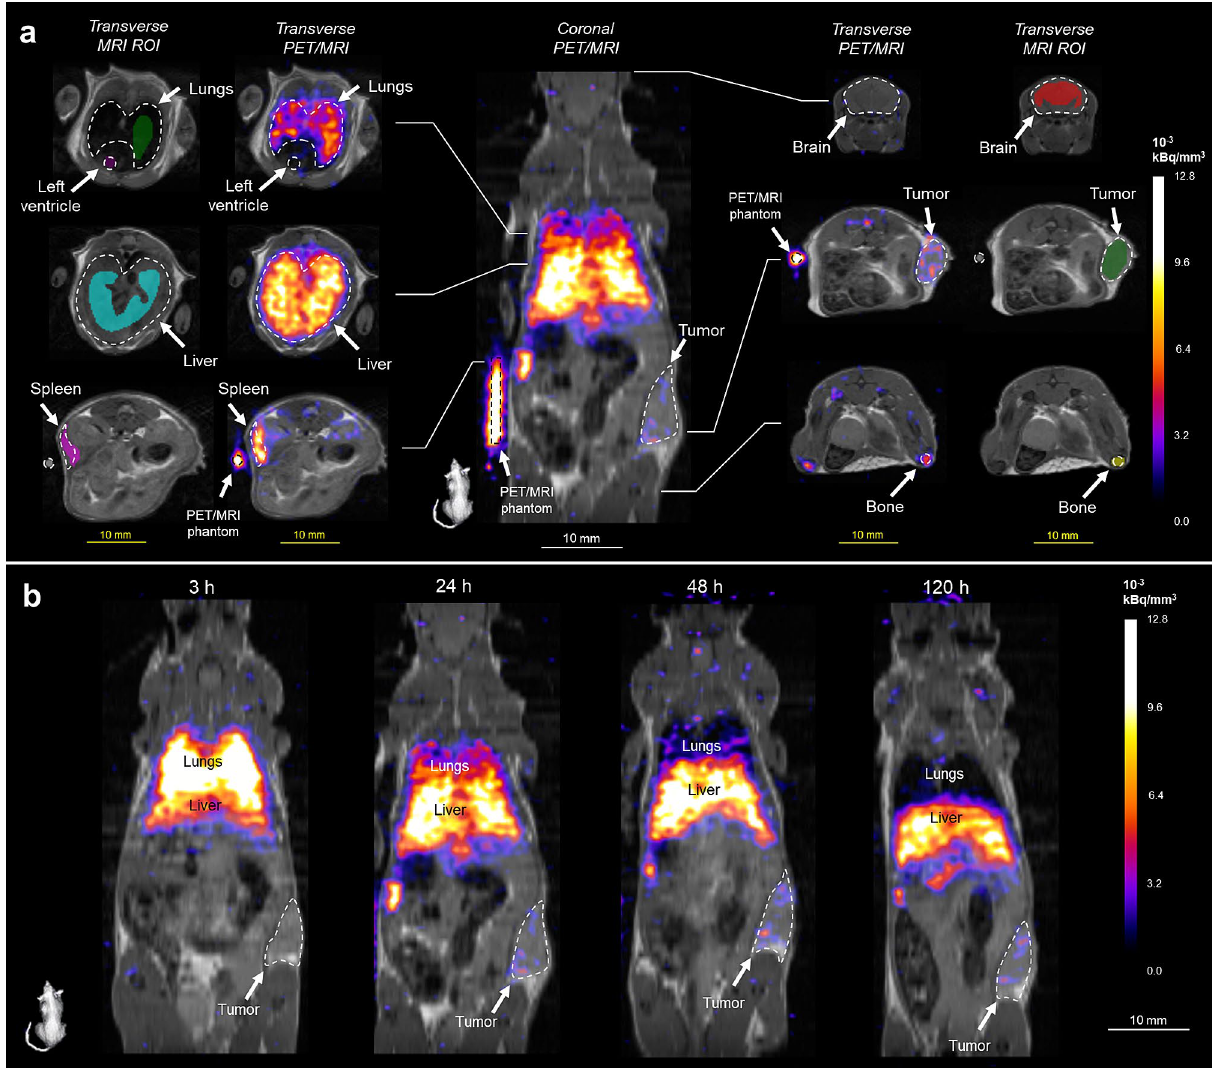
Figure 3. Representative PET/MRI of 89 Zr-oxine labeled huym-1-A-BB3z-CAR T-cells. ( a ) Central figure shows a representative coronal PET (colored: nih fire) and MRI (gray) overlay image of a Raji-bearing NSG mouse 24 h after IV administration of 89 Zr-oxine labeled huLym-1-A-BB3z-CAR T-cells (1517 kBq, 16.4 × 10 6 cells). Mouse image on the lower left shows orientation of coronal slice. Medial columns of transverse cross- sections show PET/MRI overlay images with slice positions indicated along the central coronal PET/MRI image. Lateral columns of transverse cross-sections show the same MRI slices with manually defined regions of interests (ROI) in color within the delineated organ or tissue boundaries in dashed lines. ROIs analyzed were the lungs (green), left ventricle for blood (dark magenta), liver (cyan), spleen (magenta), brain (red), tumor (dark green), and bone (yellow). ROI activity concentrations were obtained from PET images and expressed as percent injected dose per gram of tissue for CAR T-cell biodistribution analyses. Scale bars indicate 10 mm for both coronal (white) and transverse images (yellow). Color bar indicates PET activity concentration in × 10 –3 kBq/ mm 3 units. ( b ) Representative coronal PET/MRI slices at the 3, 24, 48, and 120 h timepoints following IV injection of huLym-1-A-BB3z CAR T-cells in same mouse from ( a ). Mouse on the lower left shows orientation of coronal images. Activity was observed highest in the lungs at 3 h and diminished overtime, while activities in liver and spleen increased at the later time points. Activity accumulation in tumor was evident by 24 h following 89 Zr-oxine labeled CAR T-cell injection. Color bar indicates PET activity concentration in × 10 –3 kBq/mm 3 units. White scale bar on lower right indicates 10